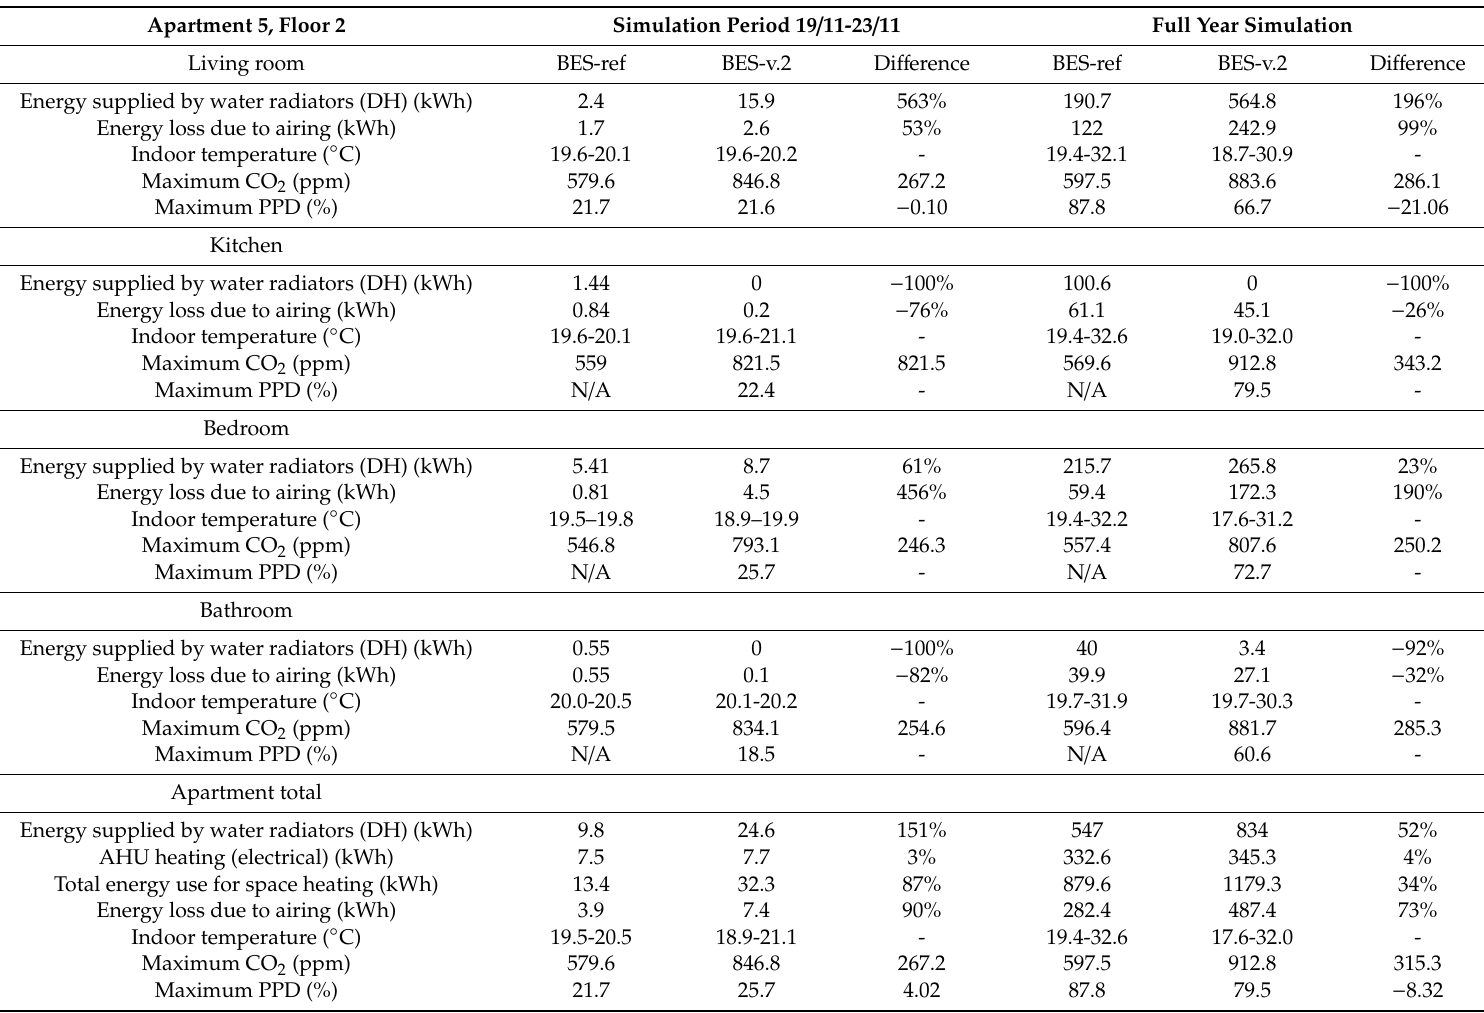
Table 14. Comparison of apartment 5, second floor, at the room level between BES-ref and BES-v.2 for the validation period and for a full-year